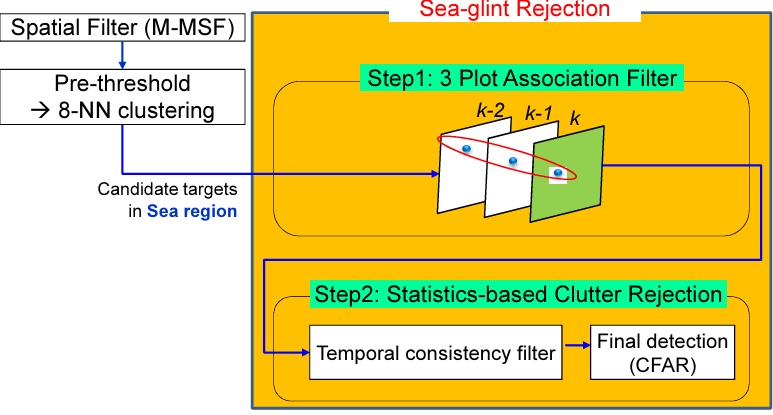
Figure 17. Proposed small target detection system. The system consists of a geometric sea region extraction part, spatial filtering part, three-plot correlation-based temporal filter part and statistics-based clutter rejection